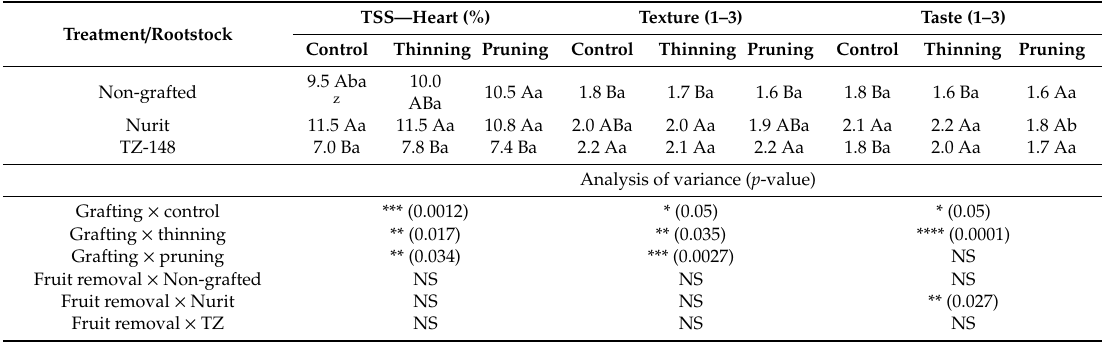
Table 3. E ff ects of rootstock, pruning and fruit-thinning on the TSS, texture and taste of watermelon fruits after 4 days of storage at 22 ◦ C ( n = 16 fruits in two